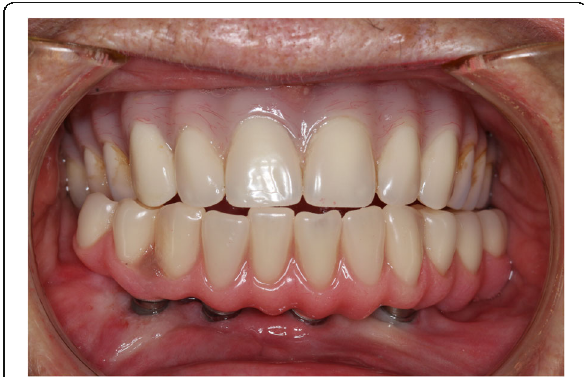
Fig. 8 Definitive implant-retained mandibular denture and pre- existing complete denture showing new prescribed